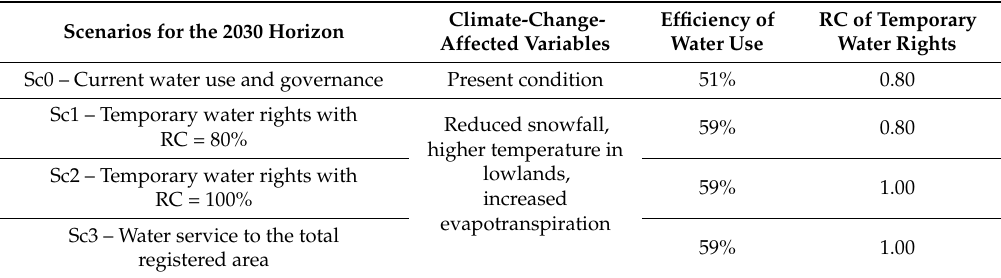
Table 4. Main characteristics of scenarios used for supply–demand water balance modeling, Mendoza River